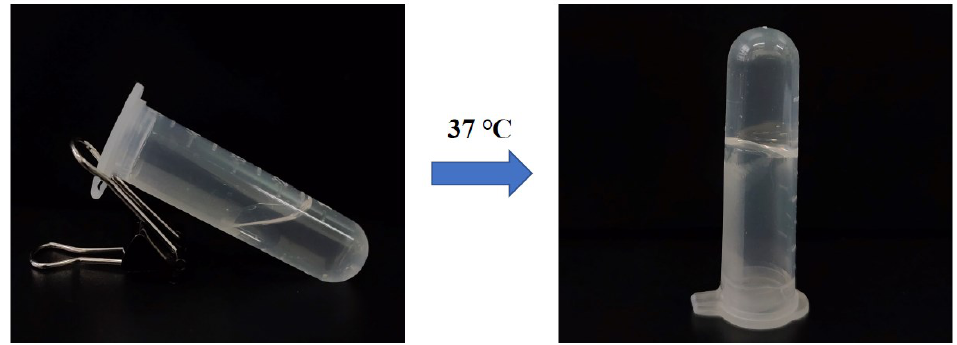
Figure 2. The morphology of EDA TSGs with the optimal prescription.